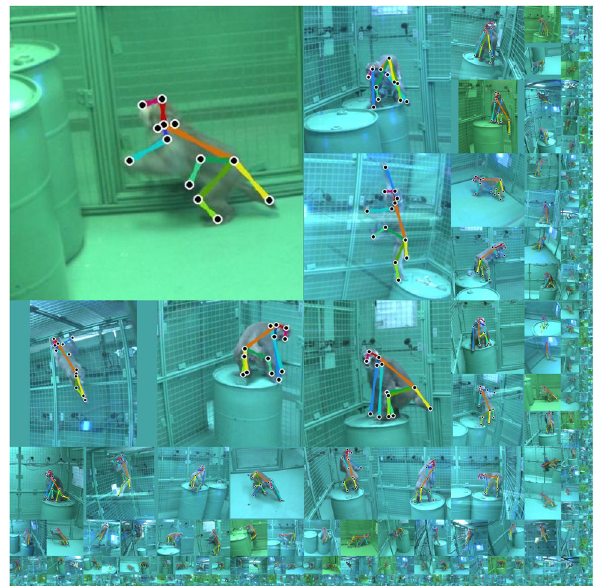
Fig. 8 Dataset. We will make OpenMonkeyPose dataset, the trained detection model, and the training code publicly available. The dataset includes 195,228 annotated pose instances associated with diverse